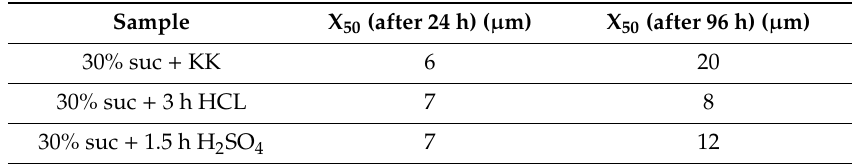
Table 1. X 50 parameter value for model sucrose solutions with the addition of kappa carrageenan and its hydrolysates (value estimated from data presented by Kami´nska-Dw ó rznicka et al., 2015 [4]). Sample